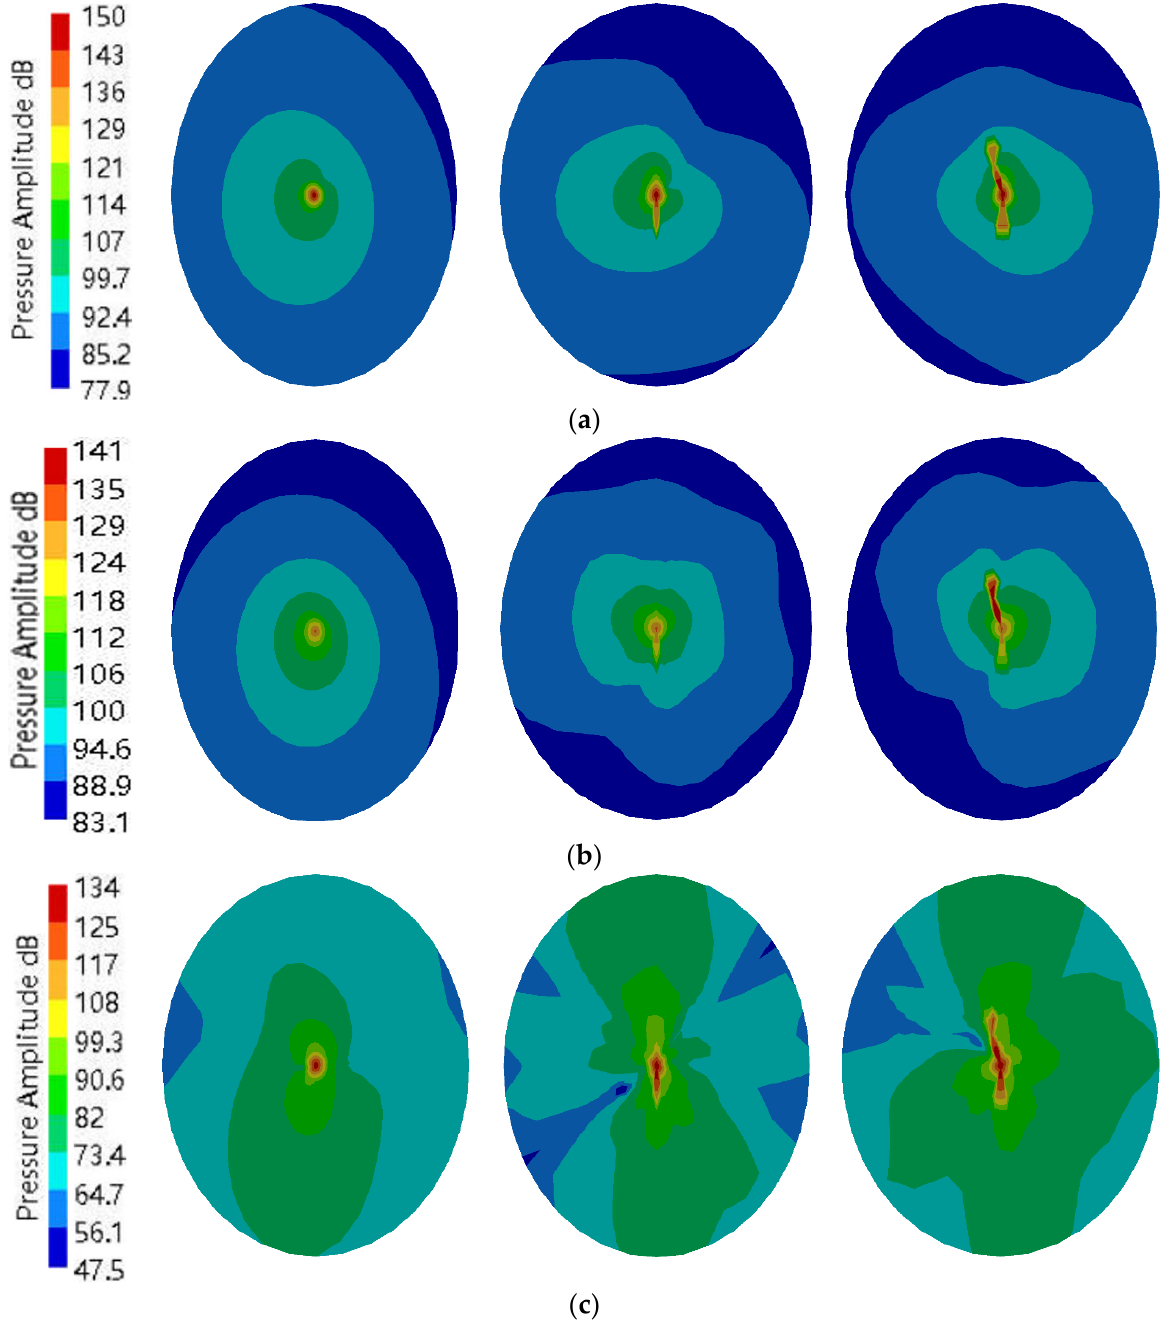
Figure 13. Amplitude distribution of sound pressure in turbine operating conditions. ( a ) 1.0 Q first ‐ order leaf frequency sound pressure amplitude. ( b ) 1.0 Q second ‐ order leaf frequency sound pressure amplitude. ( c ) 1.0 Q third ‐ order leaf frequency sound pressure amplitude.